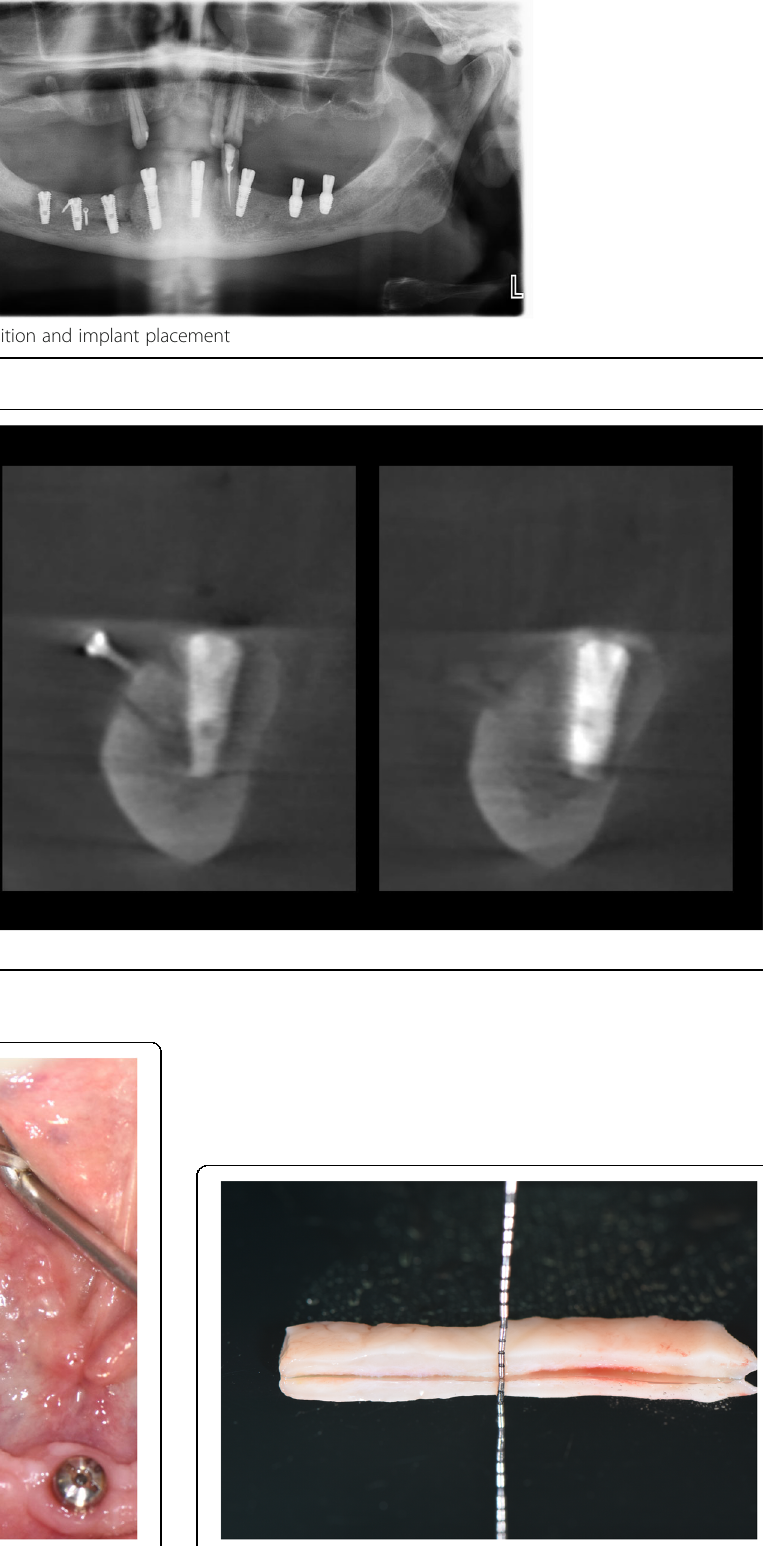
Fig. 8 Narrow band of keratinised gingiva at the second-stage surgery Fig. 9 A free gingival graft is obtained from the